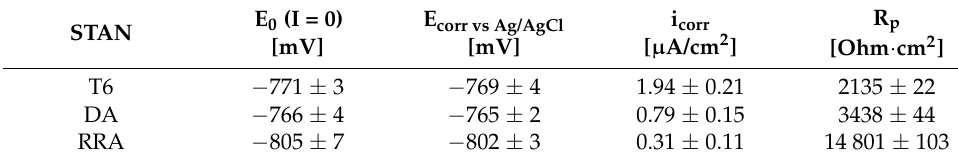
Figure 16. Example of potentiodynamic curves obtained for each heat treatment condition. Table 2. Electrochemical parameters obtained for each heat treatment